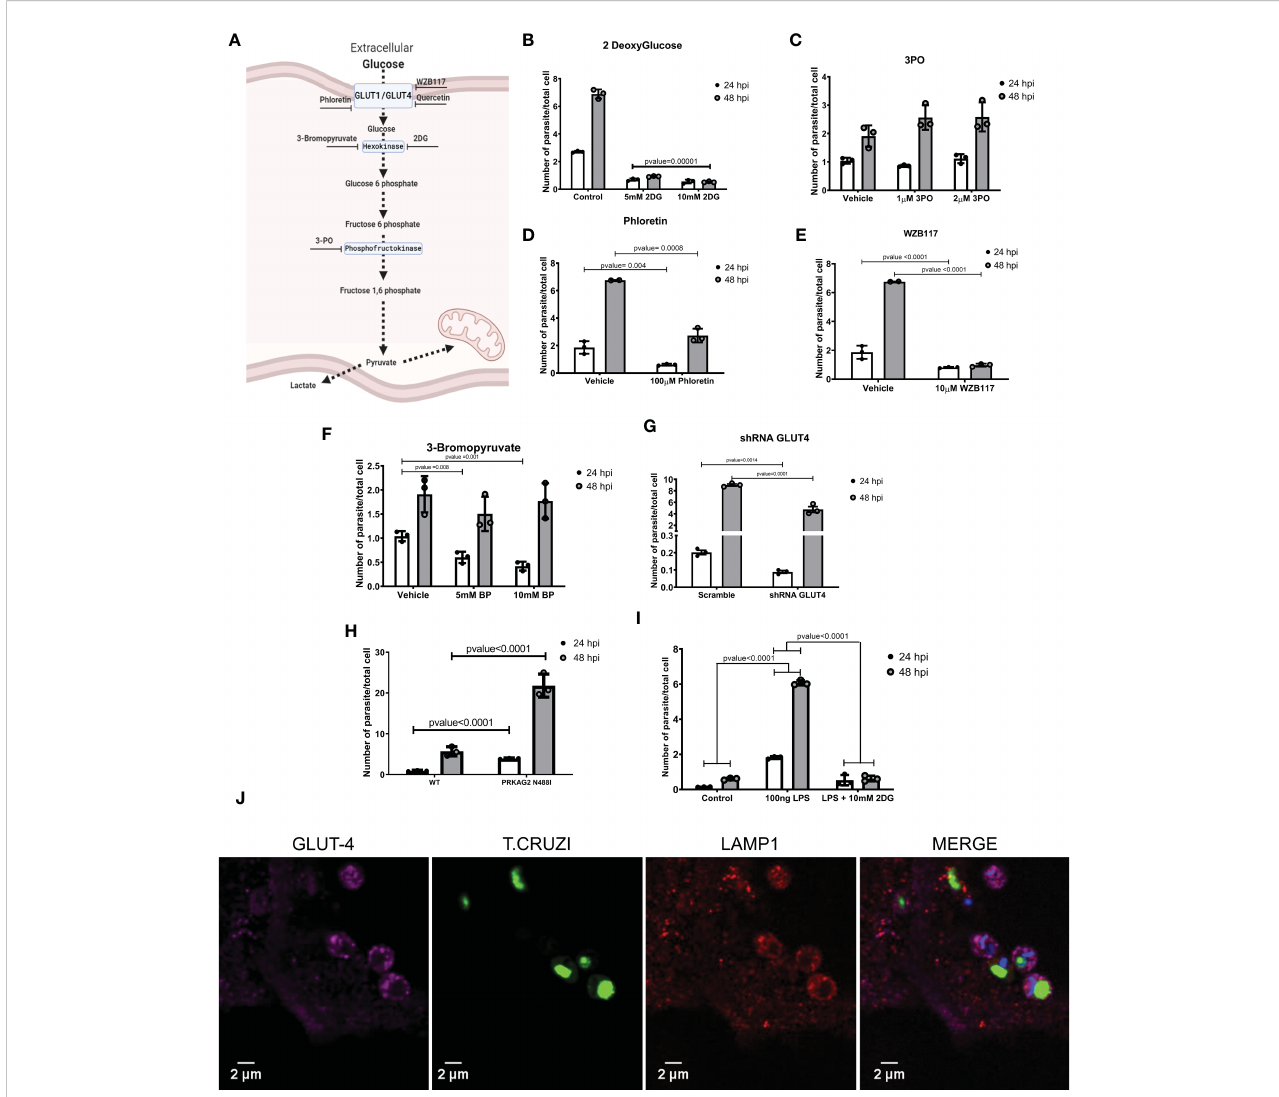
FIGURE 3 Inhibiting glycolysis impaired T. cruzi proliferation. (A) A schematic of glycolytic enzymes and inhibitors studied. (B) 2DG-treatment of iPSC-CMs concurrent with T. cruzi exposure decreased infection and cell division. (C) Inhibition of phosphofructokinase did not alter infection or parasite division. Inhibition of glucose transporters with (D) phloretin (nonspeci fi c inhibitor) and (E) WZ117 (speci fi c for GLUT1 and GLUT4) decreased infection and cell division. (F) Inhibition of hexokinase II by 3-bromopyruvate decreased intracellular parasites at 24 hpi but not at 48 hpi. (G) iPSC-CMs transduced with shRNAs targeting GLUT4 had signi fi cantly fewer intracellular parasites at 48 hpi. (H) PRKAG2-mutant iPSC-CMs with 2-fold higher GLUT4 levels show increased infection and parasite replication rates. (I) LPS-primed iPSC-CMs increased intracellular parasites at 24 hpi, while inhibition of glycolysis normalized infection rate. (J) Confocal images of fl uorescently labeled, T. cruzi -infected iPSC-CMs (3 hpi) demonstrate co-localization of GLUT4 (magenta), lysosomal membrane protein 1 (red), and T. cruzi (green). Nuclei are DAPI stained. Data re fl ect three independent replicates for each experiment. Statistical analyses used ANOVA test with Bonferroni correction and p-value<0.05 was considered signi fi